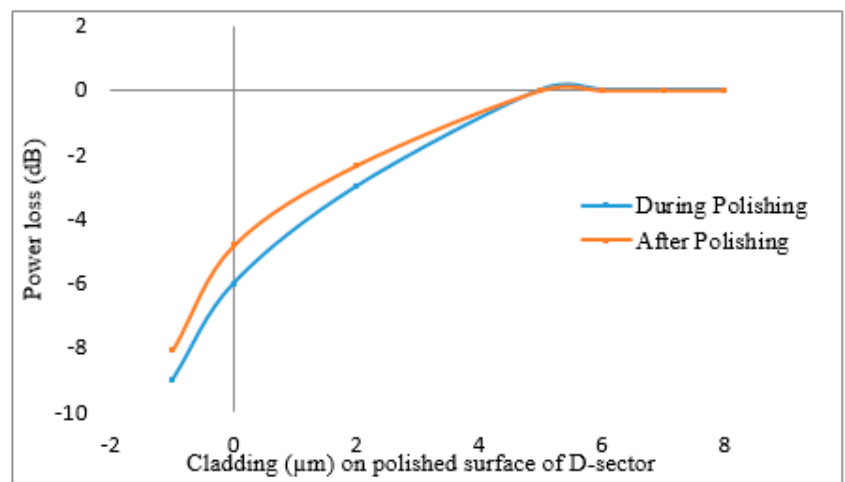
Figure 3. Average transmission power loss as a function of residual cladding on polished surface.